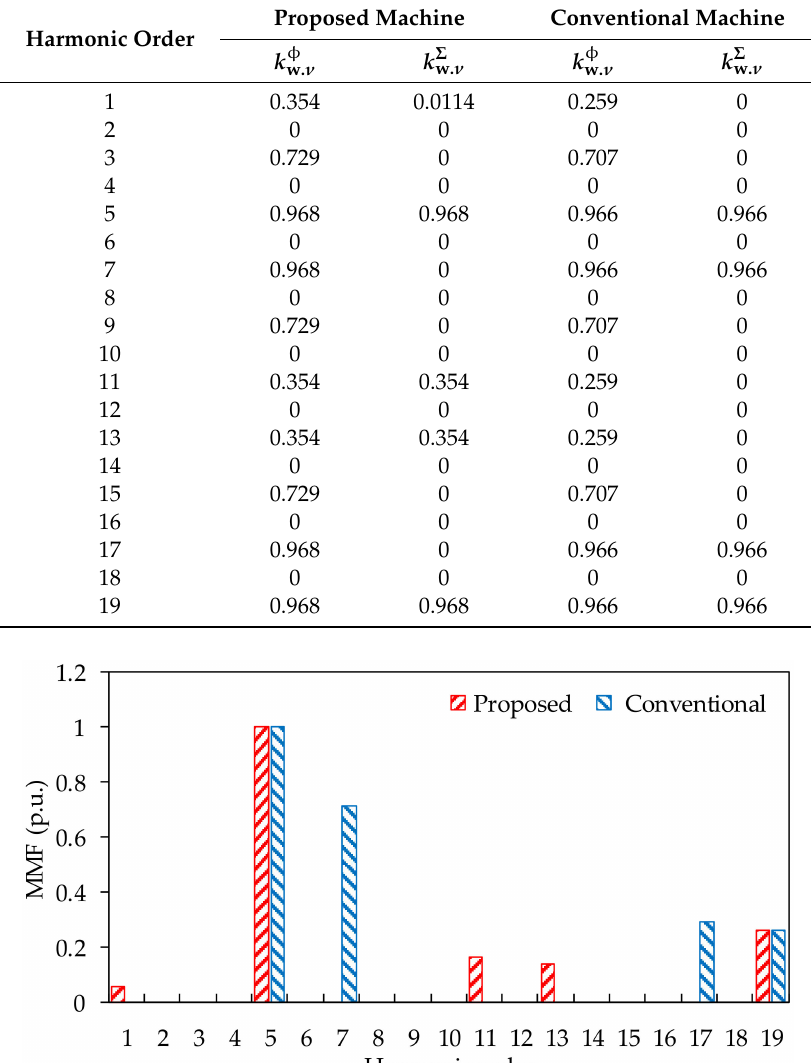
Figure 5. Winding MMF harmonics ( N 1 / N 2 = 0.6 for the winding of the proposed